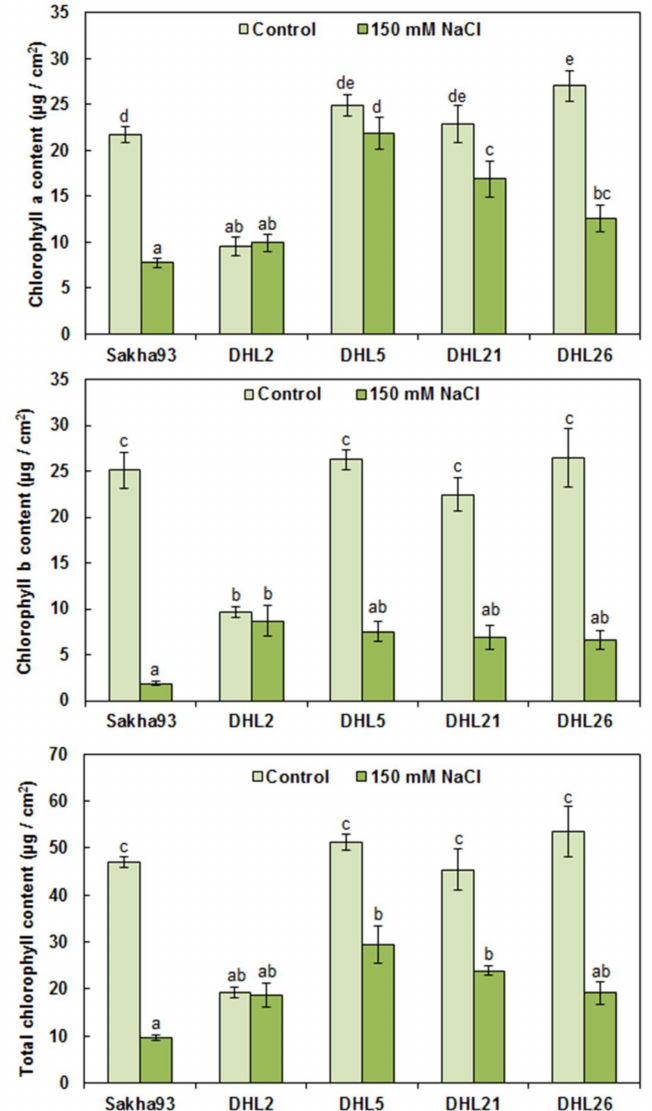
Figure 2. Effects of salinity on chlorophyll a, chlorophyll b, and total chlorophyll content of leaves of wheat genotypes. Values are presented as the mean ± SE of at least three replications, and values sharing the same letter for each treatment × genotype combination are not significantly different ( p ≤ 0.05) according to Duncan’s multiple range